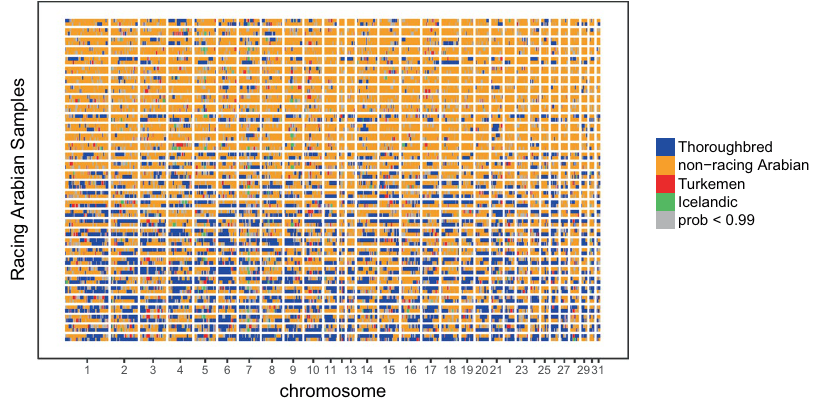
Figure 4. Admixture analysis indicates presence of Thoroughbred ancestry in Arabian horses used for flat course racing. RFMix was applied to the set of 34 “racing Arabian” samples. Segments assigned to one of four reference groups with posterior probability ≥ 0.99 are colored as indicated in the legend. No assignment was made if all posterior probabilities were < 0.99 (gray segments). Each row is a haplotype, with individuals (pairs of haplotypes) separated by horizontal white lines. Samples were ordered based on the first principal component (PC1) of the PCA in Fig. 2. See also Supplemental Fig. S5.